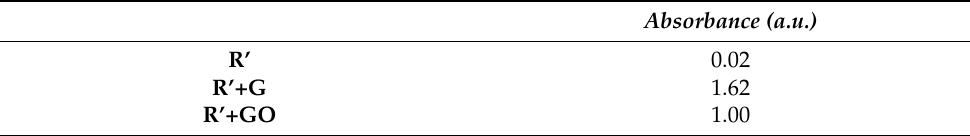
Table 4. Absorbance measured at 405